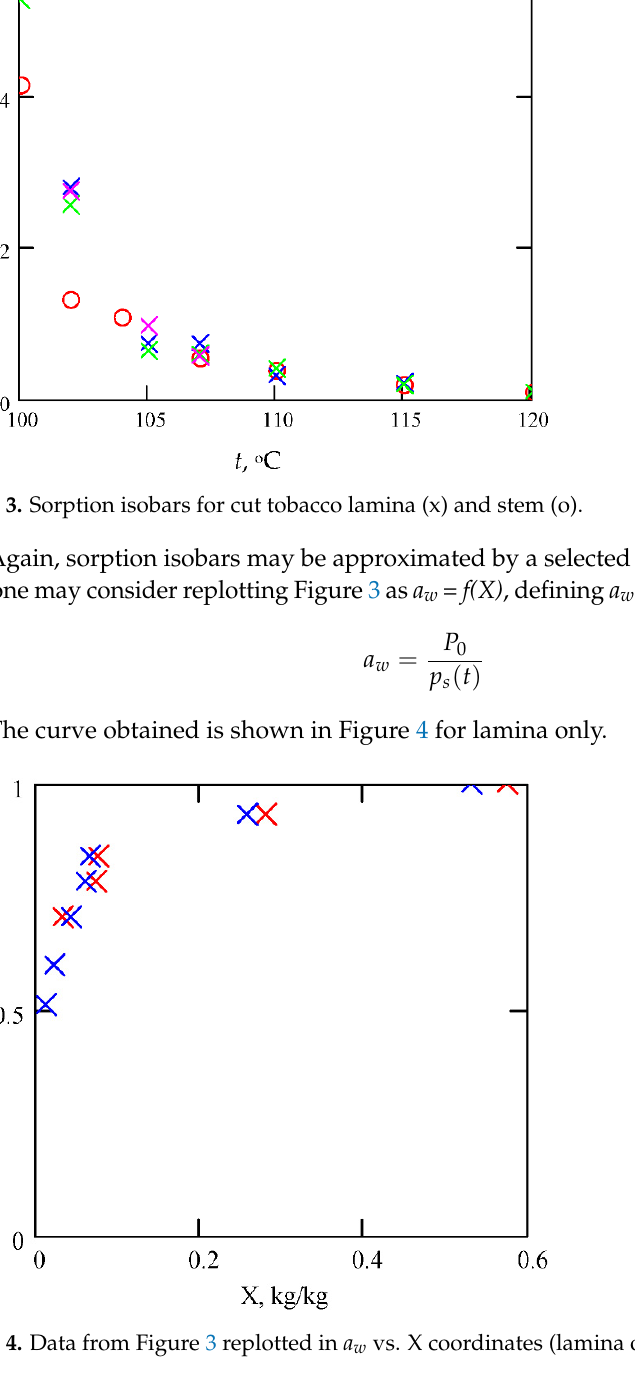
Figure 2. Schema of a setup for sorption isobar measurement at atmospheric pressure built at Lodz University of Technology [15]: 1—boiler, 2—superheater, 3—calming section, 4—steam tempera- ture measurement, 5—sample, and 6—balance.